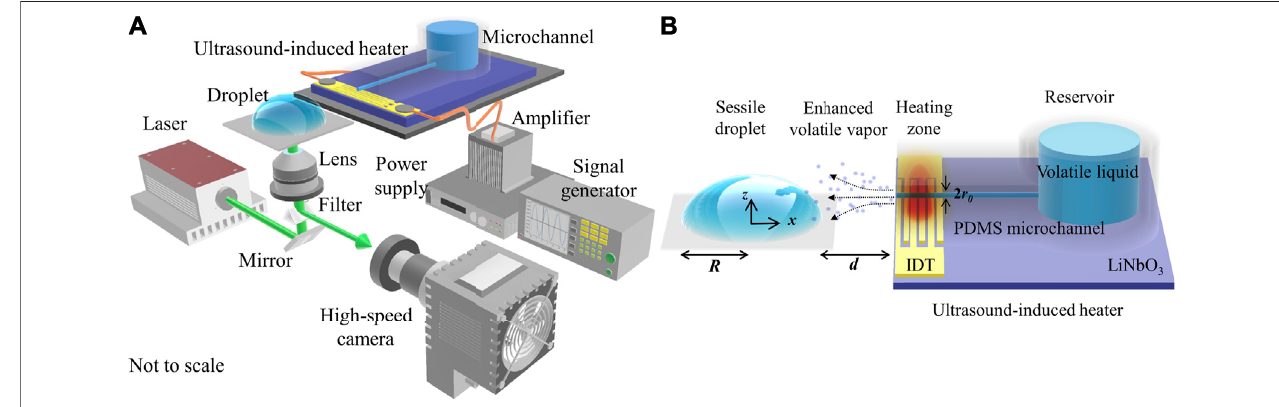
FIGURE 3 | Schematics of (A) experimental setup and (B) ultrasound-induced heating platform to enhance the vapor-mediated solutal Marangoni effect on a sessile droplet.